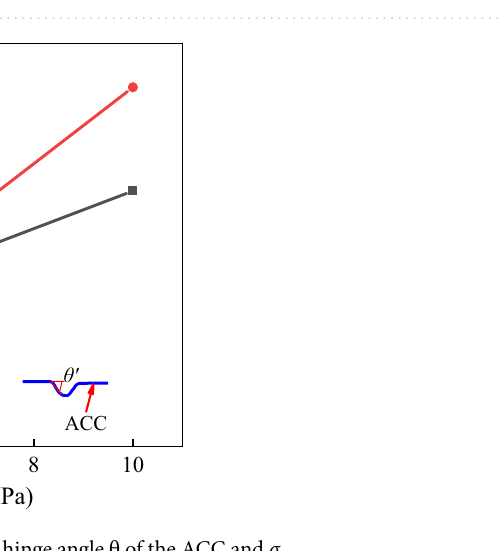
Figure 8. ACC deformation length DE, its horizontal component DF, and its vertical component FE.